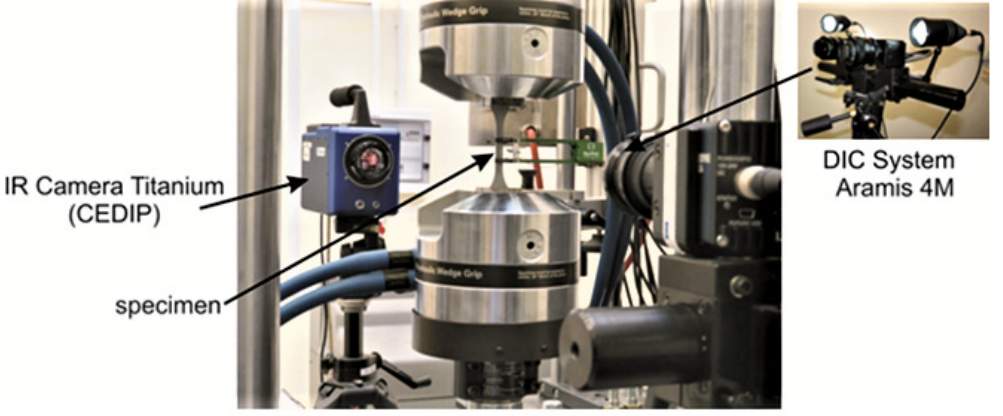
Figure 4. The measuring system.